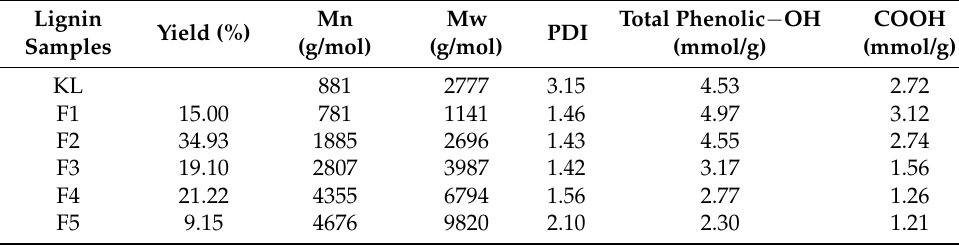
Table 1. Yields and structure information of lignin